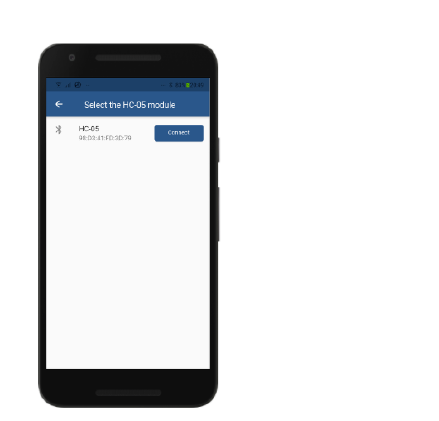
Figure 2. Sensor data collection application - Connection screen. Source: Author (2022).